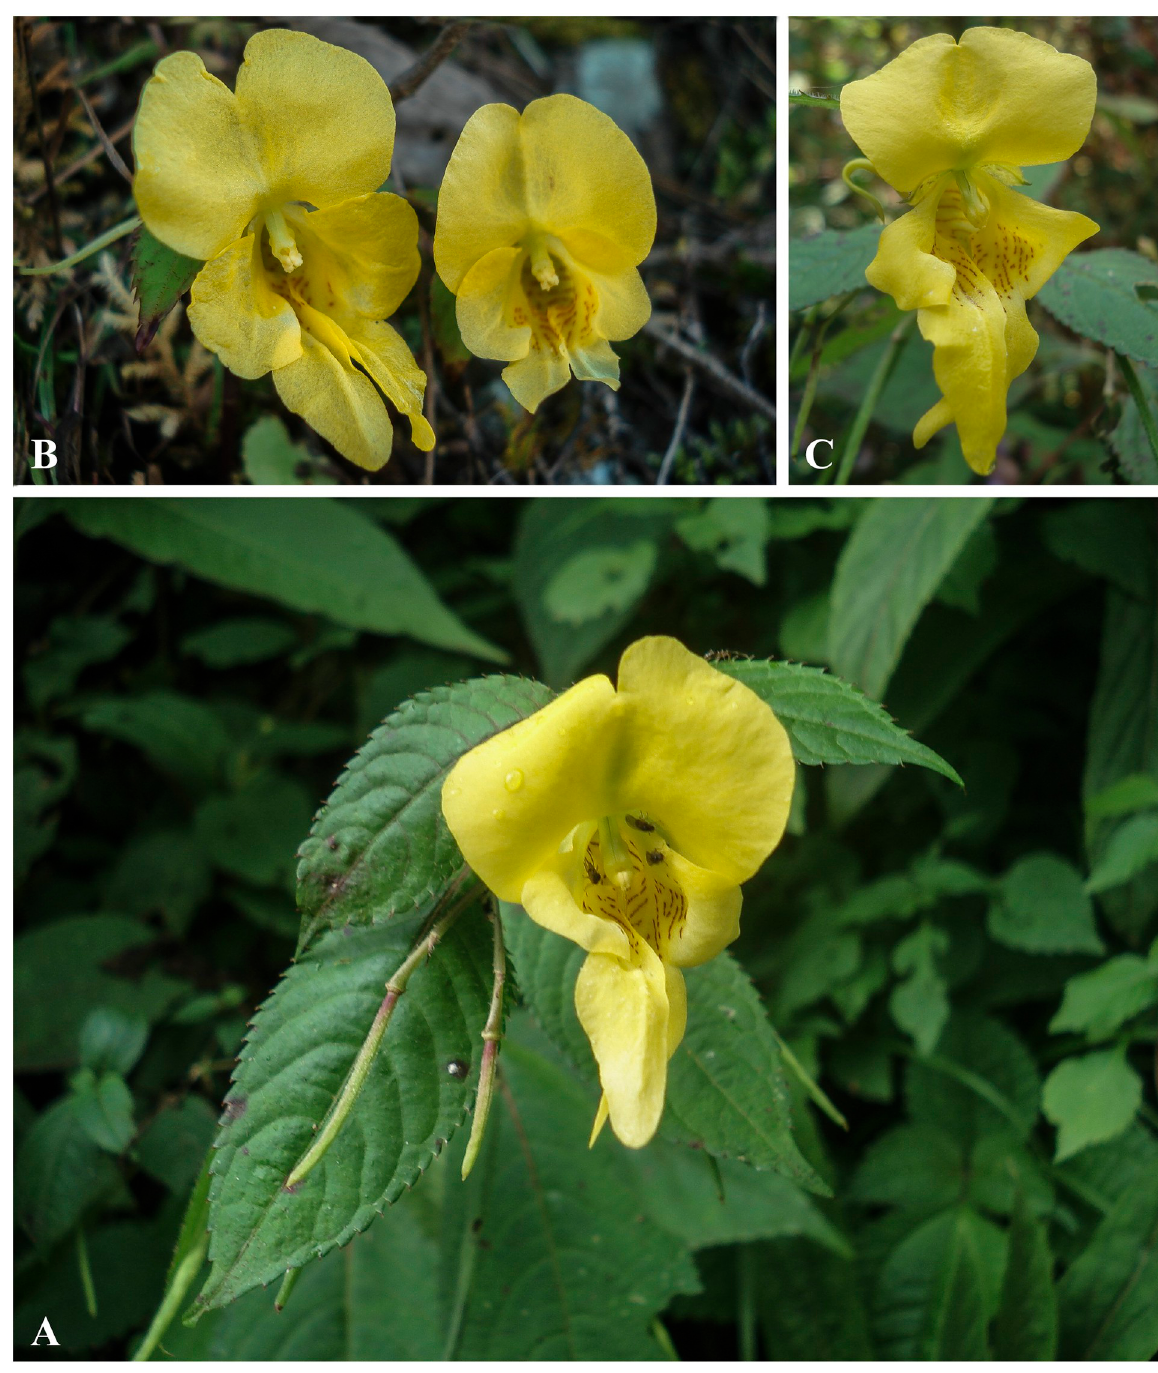
Fig 23. Impatiens scabrida A. Flowering plant; B, C. Flower (Front view). Photographs by Bhakta Bahadur